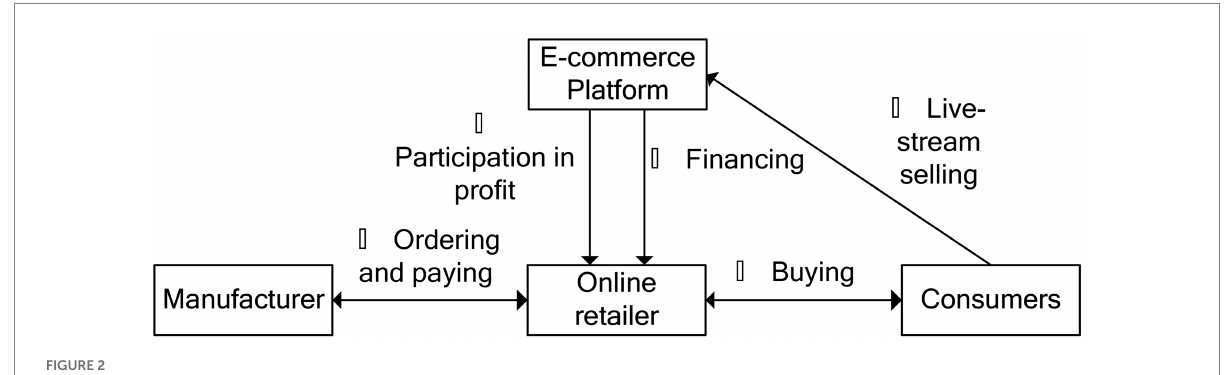
FIGURE 2 E-commerce platform financing.